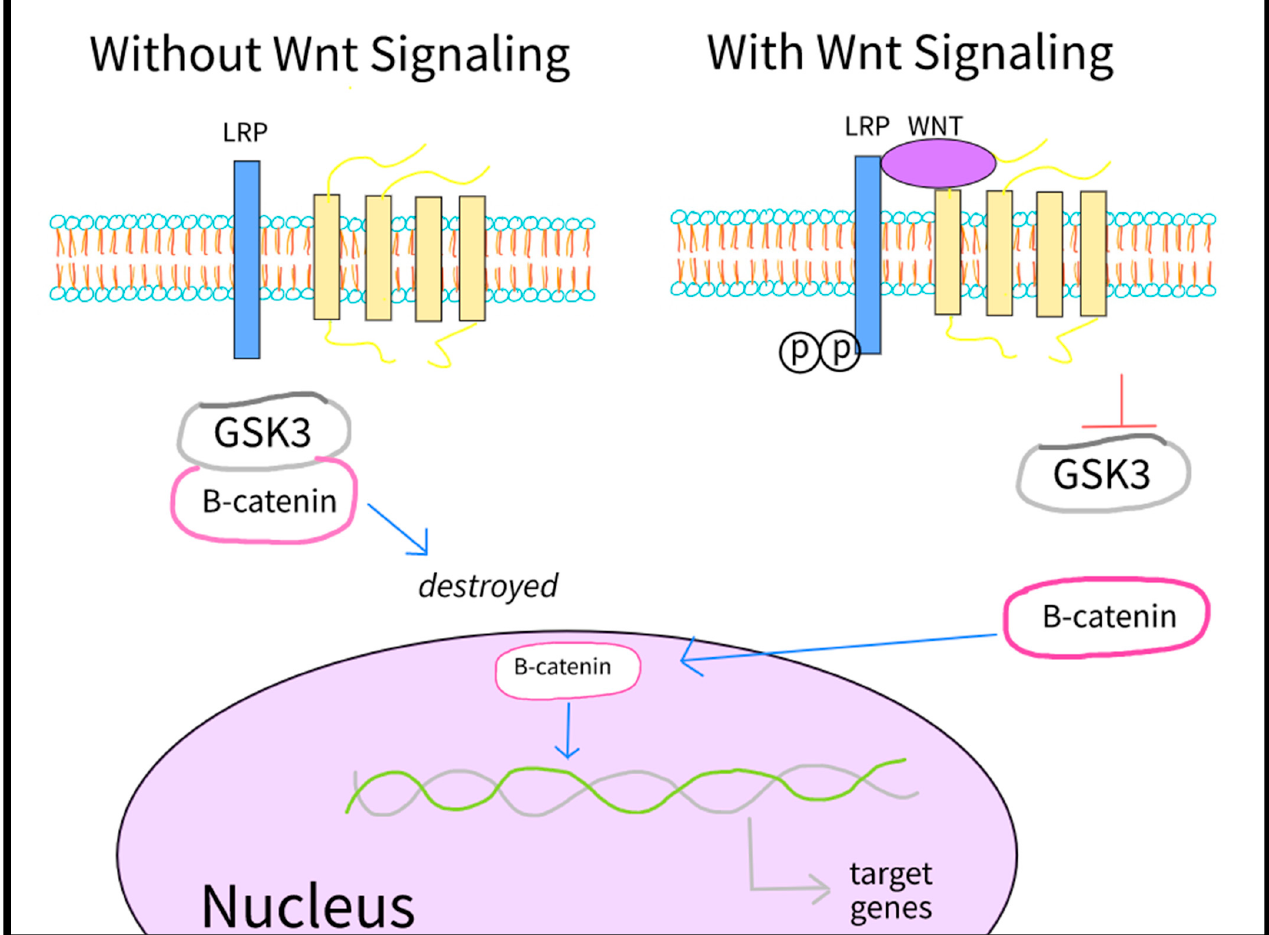
Figure 2. Inhibition of GSK3 in Wnt signaling leads to activation of β -catenin and transcription of differentiation genes [37].